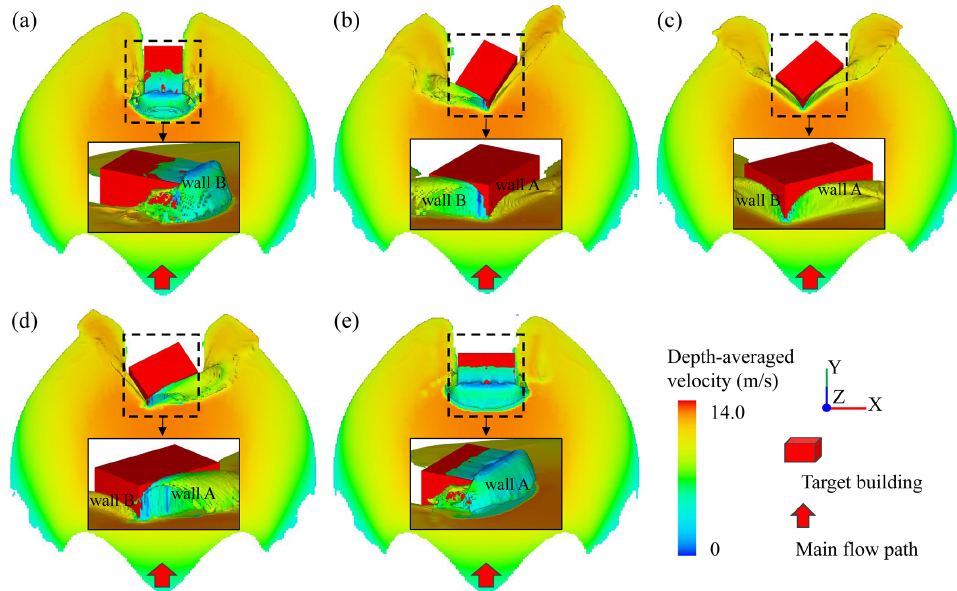
Figure 15. Snapshots for debris flow intensities in the scenarios of Orx-Op0- A null- D null at a simulation time of 8.0s. Panel (a) is the case of Or0-Op0- A null- D null, (b) is the case of Or30-Op0- A null- D null, (c) is the case of Or45-Op0- A null- D null, (d) is the case of Or60-Op0- A null- D null and (e) is the case of Or90-Op0- A null- D null.